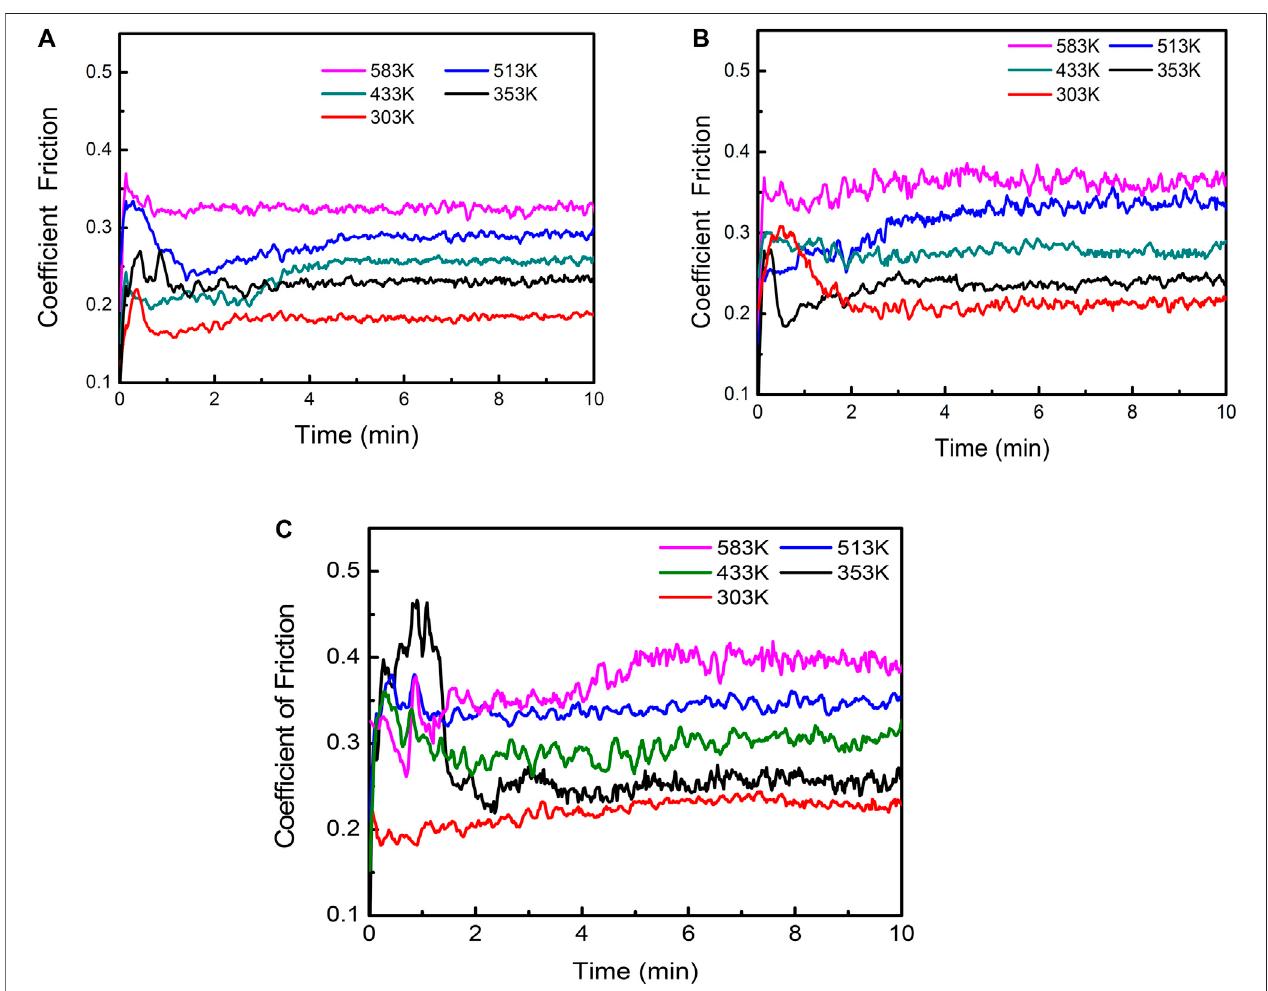
FIGURE 2 | The coef fi cient of friction of the Ti-based BMG sample tested at different temperatures with an applied load of (A) 1.5 N, (B) 2.5 N, and (C) 3.5 N.